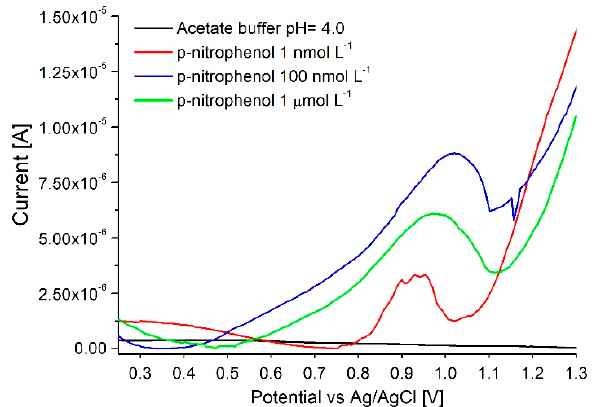
Figure 8. Detection of p-nitrophenol on pencil electrodes. Array of 16 posts, flow of 100 µL min − 1 , pencils regenerated using adsorptive displacement, with iodine.